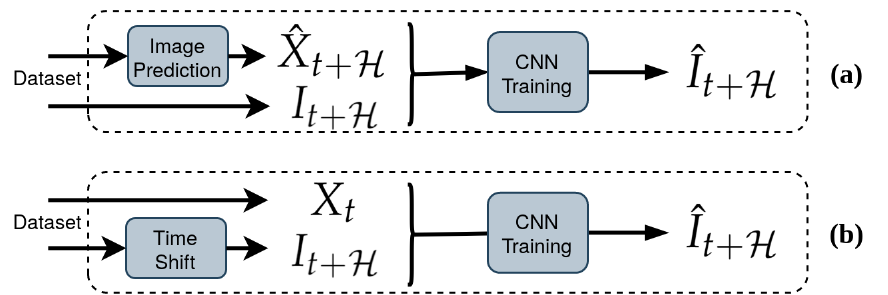
Figure 1. Irradiance forecasting using an image regression CNN with either ( a ) an external module for future sky image prediction or ( b ) irradiance values shifted backwards in time by H